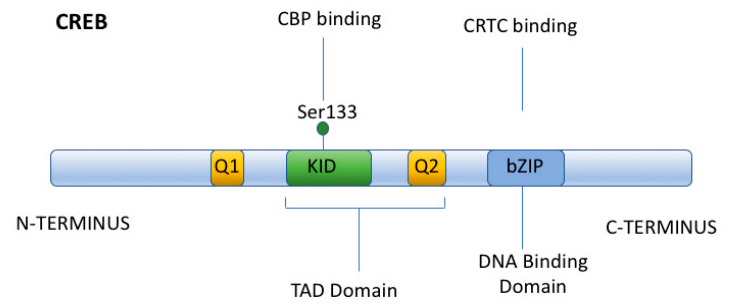
Figure 3. CREB Structure. CREB has two glutamic acid rich domains, Q1 and Q2; a Kinase Inducible Domain (KID); and a bZIP domain, which promotes DNA binding and CREB dimerization. PKA phosphorylates CREB at Ser133 within the KID domain, which then serves as a CBP binding site. The bZIP domain mediates CREB binding to CRTCS.